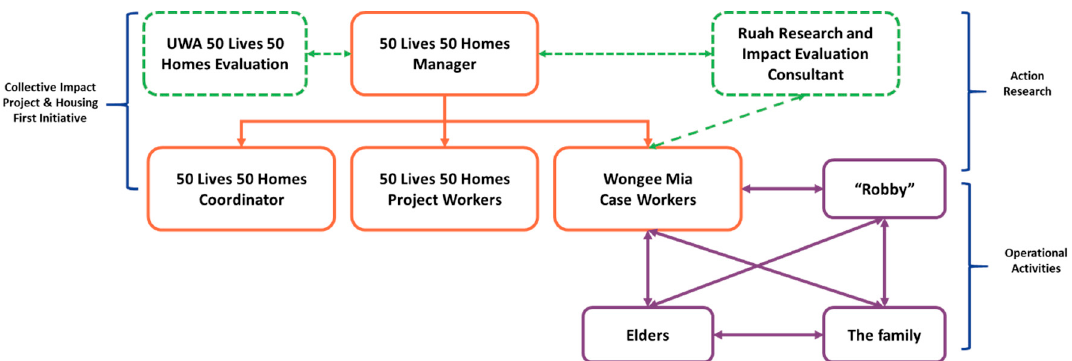
Figure 1. The 50 Lives 50 Homes and Wongee Mia governance structure.